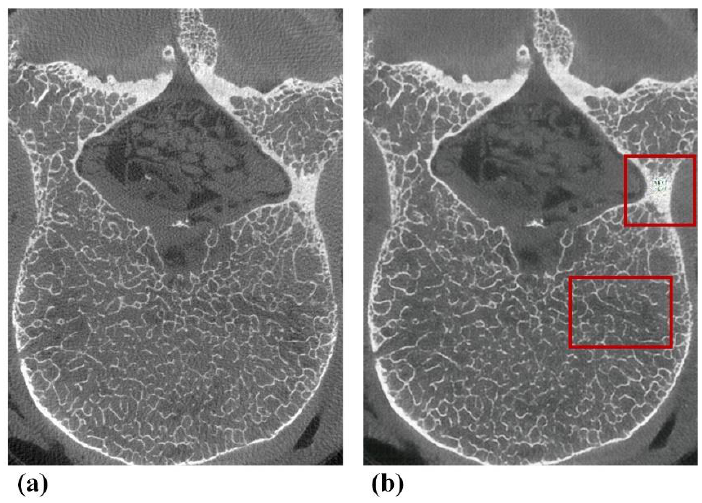
Figure 7. Typical examples of defects of pix2pixHD-derived micro-CT-like images found in subjective assessments. ( a ) Gold-standard micro-CT image. ( b ) Corresponding pix2pixHD-derived micro-CT-like image with noise in the appendage area and a slightly blurred area in the vertebral body. In addition, the observers subjectively determined the sharpness and trabecular tex- ture scores of micro-CT-like images to be lower than those of micro-CT images ( p < 0.001), which is consistent with the trend of our objective metric results (SSIM and FID) and tra- becular bone measurement results (Tb.Th and Tb.Sp). This result arises because the method used is based on image-by-image mappings with insufficient consideration of the correlation between adjacent images. This caused the bone trabecular details to have un- reasonable missing and abnormal textures, which reduced the corresponding score in the subjective evaluation. To solve the above problems, we need to increase the number of samples, build models that can extract association information between images and opti- mize the parameters of the training models in future work. Regarding all trabecular bone structural measurements (BV/TV, Tb.Th and Tb.Sp) in our study, the correlation of their values computed from micro-CT and pix2pixHD-de- rived micro-CT-like images was very high (R > 0.88) and better than the correlation com- puted from micro-CT and MDCT images. The mean values of the measurements in our study were lower than those of the gold standard. Previously published in vitro studies on the feasibility of bone structure measurements using MDCT on vertebral bodies re- ported similar results for BV/TV. Issever et al. [5] reported a correlation coefficient of 0.86 (coefficient of determination, R 2 ) for BV/TV measured in vertebrae specimens. However, the correlation between Tb.Th and Tb.Sp in the results of Issever et al. [5] was considerably weaker and rare (R 2 = 0.19 – 0.26), which is consistent with our MDCT image results. Guha [6] and Chen [7] explored the correlation between trabecular bone structural measure- ments of MDCT and the corresponding micro-CT images using in vitro tibial and distal radius specimens. Although the anatomical positions of the study specimens were differ- ent, the correlation coefficients of Tb.Th and Tb.Sp was also relatively moderate (R < 0.80, Pearson). In addition, note that the mean values of MDCT-derived Tb.Th measured by the existing studies were greater than those of the gold standard, which is the same as our